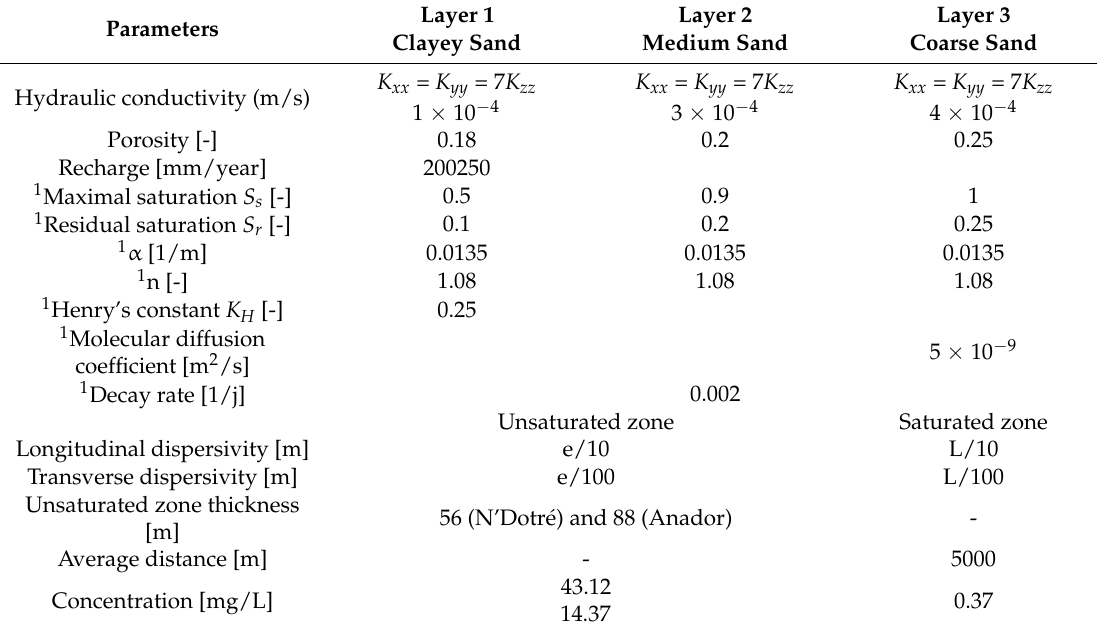
Table 4. Transport model input